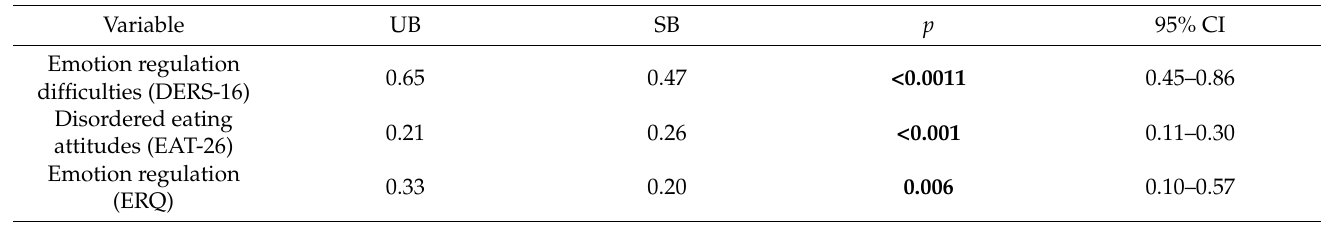
Model 6: College life alcohol salience score as the dependent